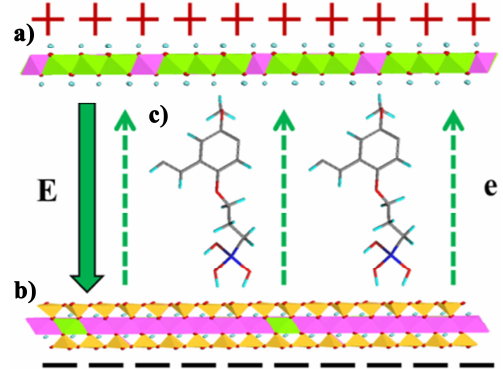
Figure 1. The sketch map of APPV in electronic microenvironment (EME) between the montmorillonite (MMT) and layered double hydroxides (LDHs) monolayers. ( a ) MgAl-LDHs (MMT) and layered double hydroxides (LDHs) monolayers. ( a ) MgAl-LDHs monolayer; ( b ) MMT monolayer; ( b ) MMT monolayer; ( c ) Poly [5-methoxy-2-(3-sulfopropoxy)-1,4-phenylenevinylene] monolayer; ( c ) Poly [5-methoxy-2-(3-sulfopropoxy)-1,4-phenylenevinylene] (APPV). In this figure, ( APPV). In this figure, the pink stands for aluminum element, green stands for magnesium element, the pink stands for aluminum element, green stands for magnesium element, yellow stands for yellow stands for silicon element. silicon